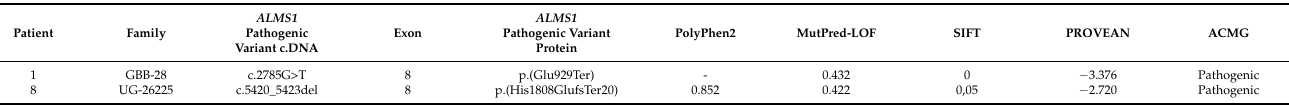
Table 3. Scores obtaining from the in silico analysis of pathogenicity for the 2 novel mutations p.(Glu929Ter) and p.(His1808GlufsTer20) and their classification according to American College of Medical Genetics and Genomics (ACMG) guidelines. The 4 programs used for this analysis were: PolyPhen2, MultiPred-LOF, SIFT and PROVEAN.